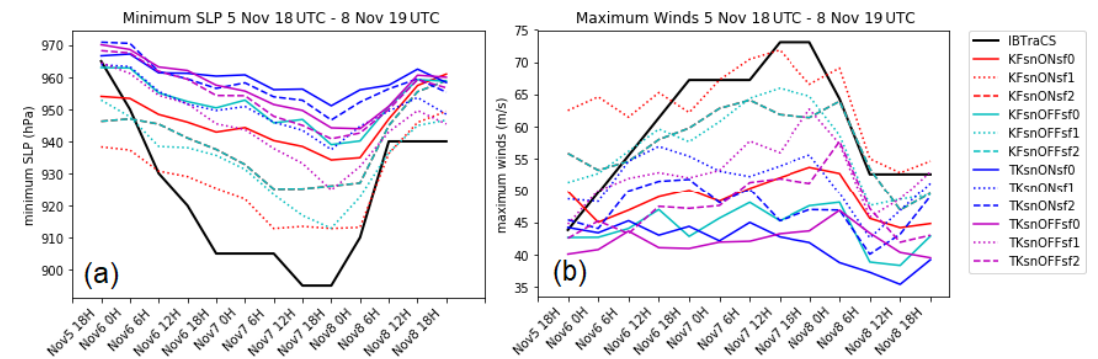
Figure 4. Time series of intensity (a) for minimum sea level pressure (hPa) and (b) maximum winds (ms − 1 ) for the sensitivity experiments classified according to experiment groups: Kain–Fritsch (KF) convection scheme, Tiedtke (TK) convection scheme, with spectral nudging (snON), without spectral nudging (snOFF), surface flux option 0 (sf0), option 1(sf1), and option 2 (sf2). The x axis is the analysis period between 18:00UTC on 5 November 2013 and 18:00UTC on 8 November 2013.